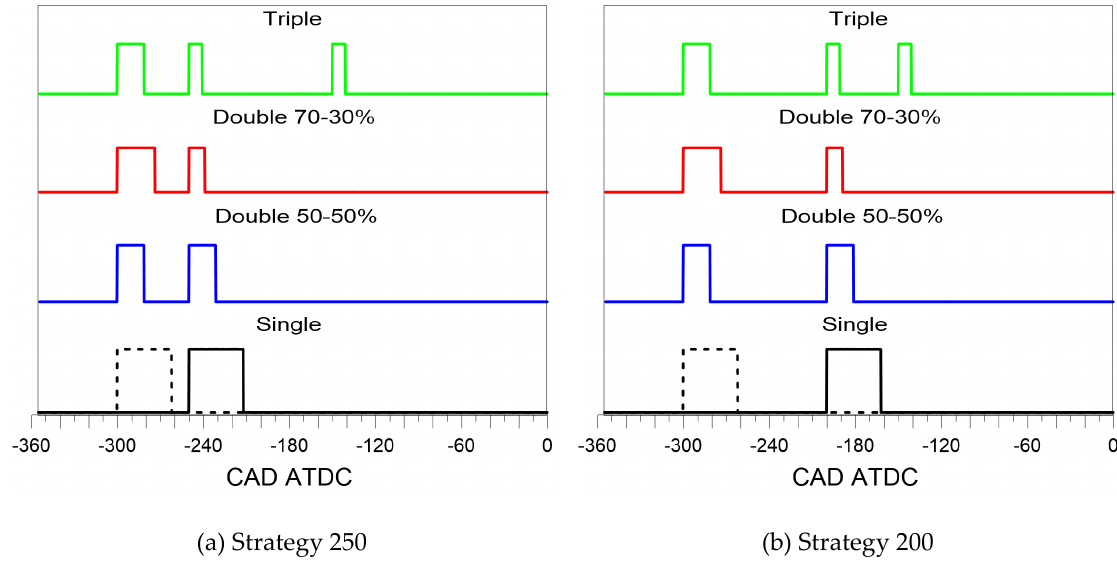
Figure 2 . Fuel injection strategies listed with respect to the position of the second injection pulses: -250 CAD ATDC ( a ) and -200 CAD ATDC ( b